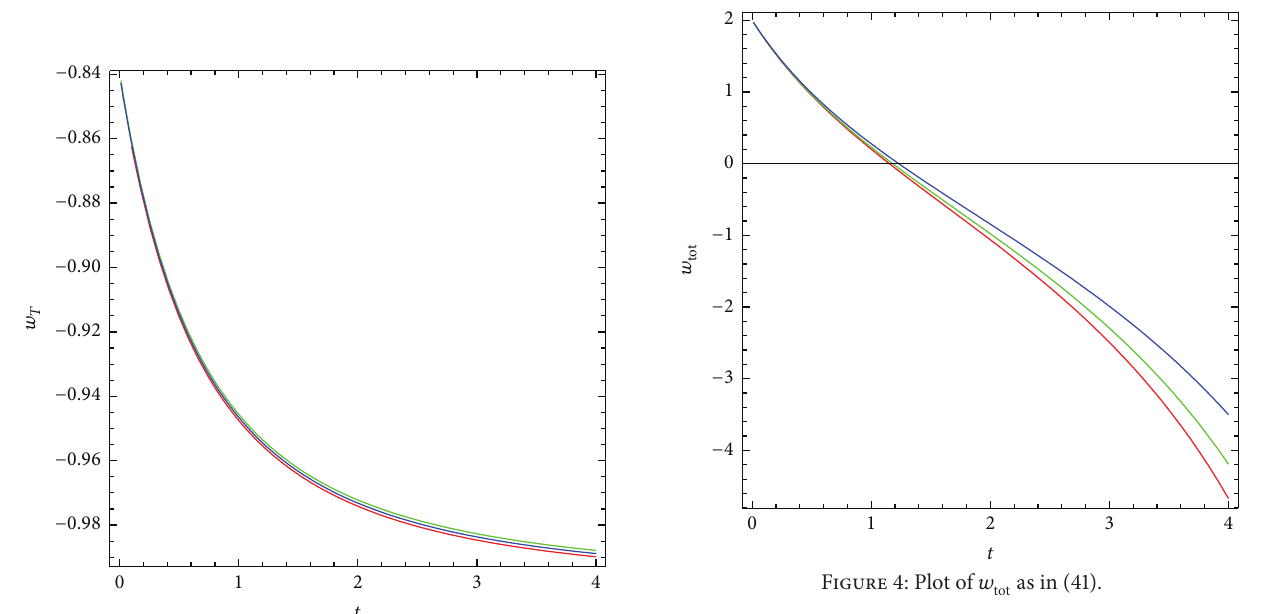
Figure 1: Reconstructed 𝑓(𝑇) (35) and we see that 𝑓(𝑇) → 0 as 𝑇 → 0 .